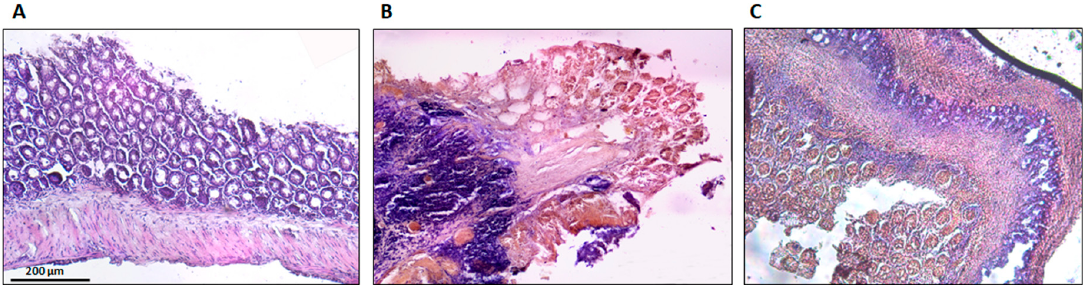
Figure 8. Effect of the spearmint extract administration on the histological features of colon inflammation. ( A ) Sham group, ( B ) TNBS group, ( C ) TNBS + spearmint group. Original magnification × 100. Scale bar equals 200 µm.